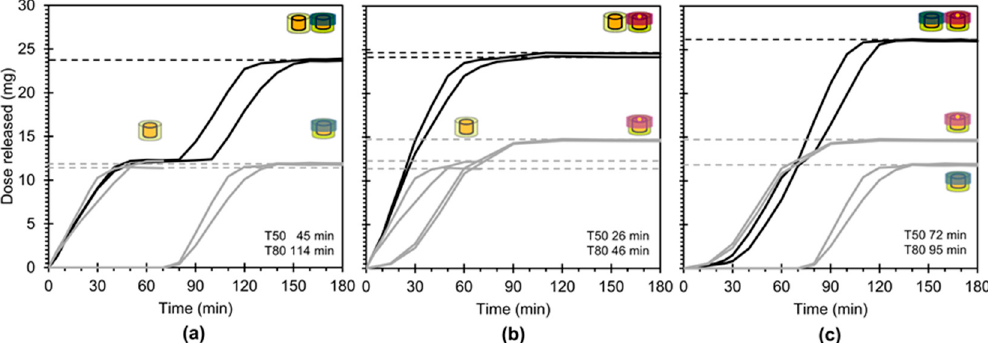
Figure 9. Dose released (mg) from dosage forms comprising two dissimilar module variants: ( a ) MV1 + MV2; ( b ) MV1 + MV3; and ( c ) MV2 + MV3. As a reference, solid grey lines indicate dose released from single module variants. Data is presented as the minimum and maximum of n = 2 samples. Mean T50 and T80 values for the dosage forms are displayed in the bottom right of each figure. The dose released (mg) corresponds to the complete drug release (100%) in all cases. As